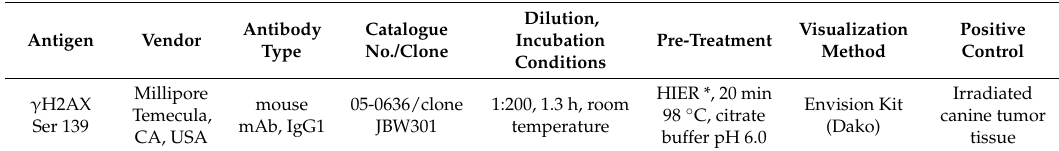
Table 5. Antibodies and incubation conditions. Primary antibody, treatment, and incubation